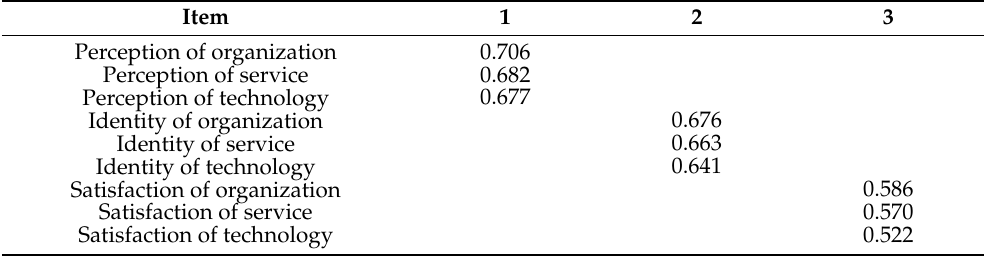
Table 1. Results of factor analysis after rotation.